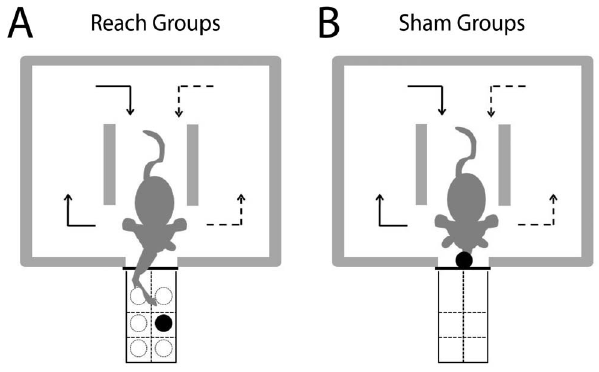
Figure 1. A nontrivial forelimb reach-and-grasp task for the rat. Adult rats were trained to perform either a forelimb reach-and-grasp task ( Reach groups) or a sham version of the task ( Sham groups) for either 5 days ( Reach , N=4; Sham , N=4) or 12 days ( Reach , N=4; Sham , N=4) before tissue harvest. A , Behavioral setup for the Reach groups. In each trial a food pellet was placed at one of six possible slots arranged in three rows at different distances from the animal (near, mid, and far slots) and two columns that were ipsilateral and contralateral to the animal’s preferred limb, respectively. The task goal was to reach and grasp the pellet using the preferred limb with single or multiple reaches. A reach was defined to be any hand trajectory from the box to the shelf area that crossed the border between the box and shelf (indicated by the thick black horizontal line), and then back to the box by crossing the same line. B , Behavioral setup for the Sham groups. In each trial the pellet was placed in the slit. Because the pellet was easily accessible, the rat naturally retrieved the reward with its tongue without using its forelimb. In all groups, the animal was conditioned to initiate a new trial by turning down either the left (left-handed rats, dotted-line arrows) or right (right-handed rats, solid-line arrows) aisle from the central